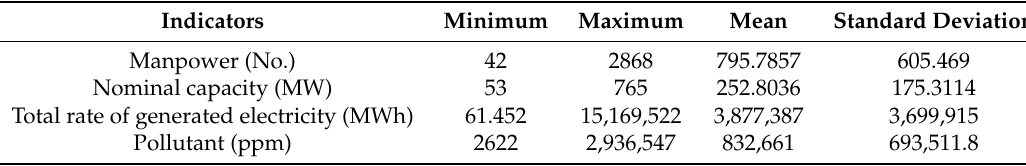
Table 1. Descriptive statistics for 56 electricity producing power